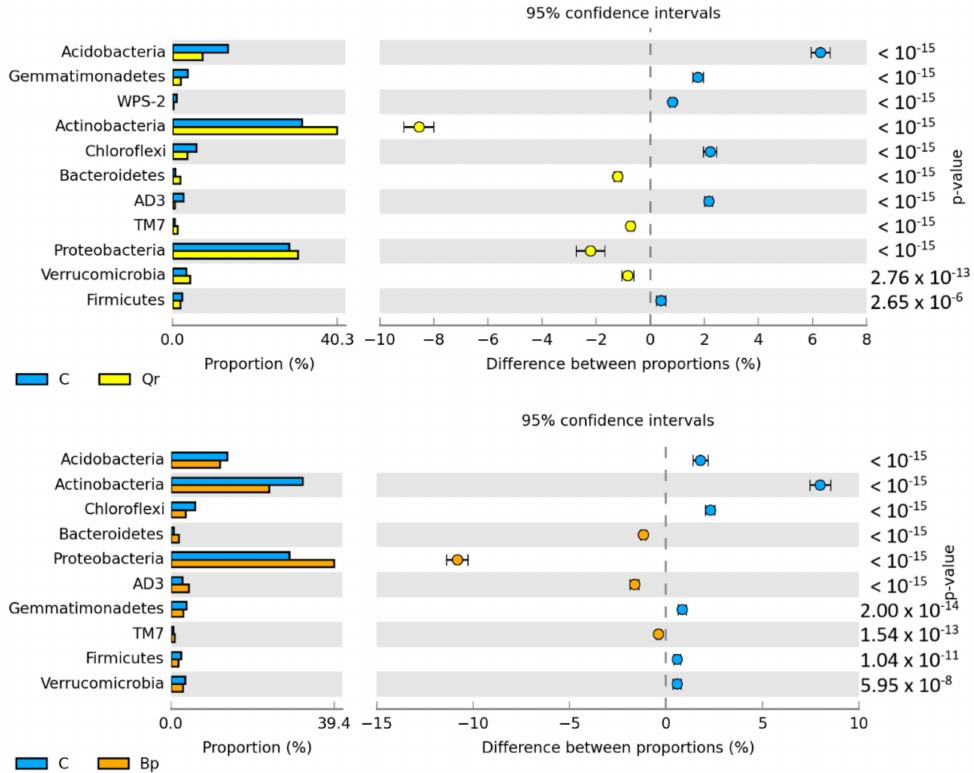
Figure 6. The relative abundance of the dominant phylum bacteria in forest soils with the difference between the proportions ≥ 1%. C—non-afforested land, Pa— Picea abies L., Ps— Pinus sylvestris L., Ld— Larix decidua M., Qr— Quercus robur L., and Bp— Betula pendula